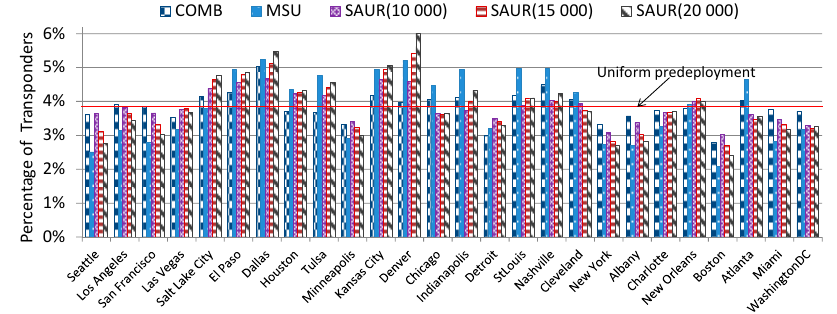
Figure 9. Placement of transponders in nodes of network US26 for traffic profile TP B as a function of various algorithms.